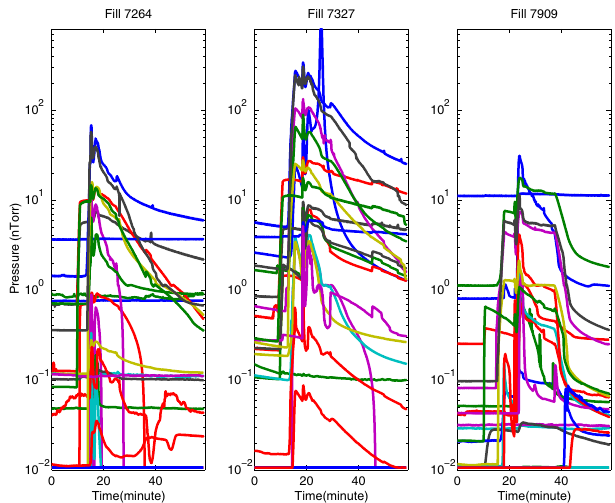
FIG. 2. (Color) The pressure rise in 24 single beam long straight sections in RHIC during the beam injection and acceleration, for the fills 7264 and 7327 in run 2005, and the fill 7909 in run 2006.